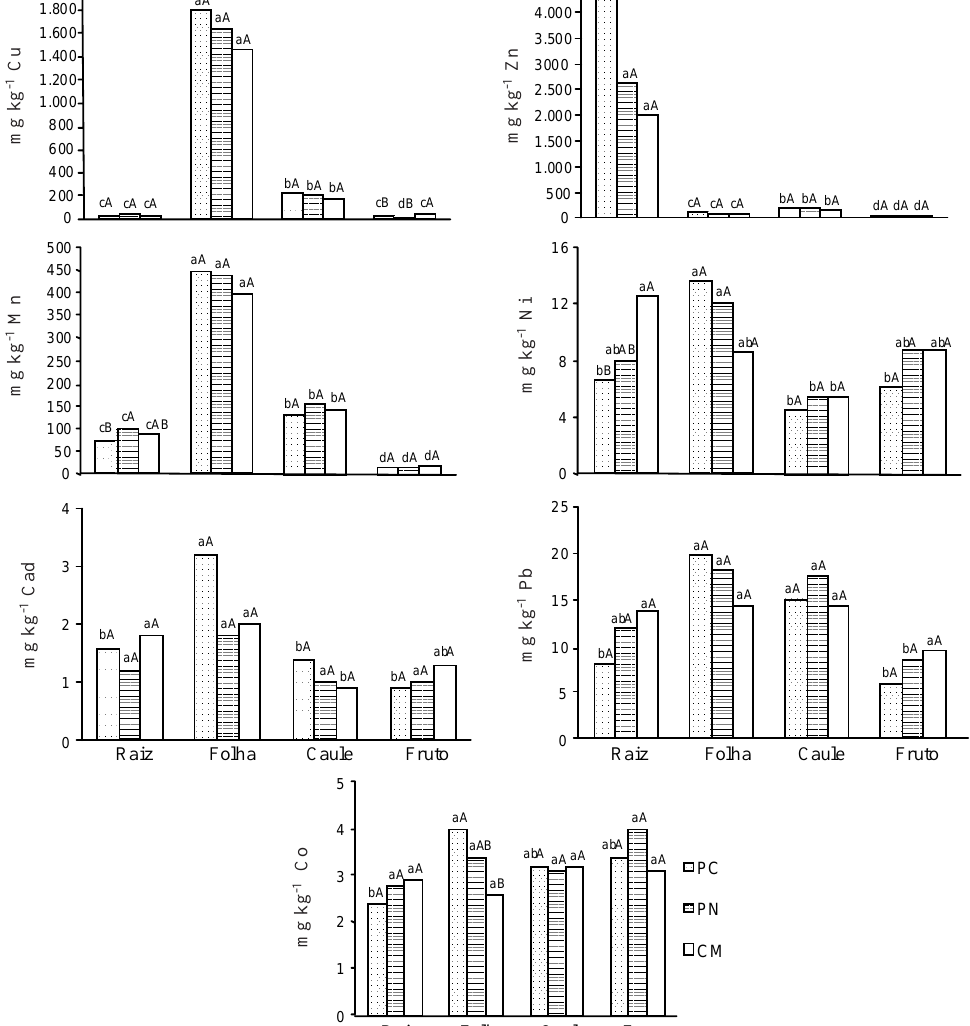
Figura 2. Teores de metais pesados em partes da planta de tomate, nos quatro sistemas de preparo do solo. Médias seguidas das mesma letra minúscula, para órgãos da planta, e maiúscula, para sistema de preparo do solo, não diferem significativamente pelo teste de Tukey a 5 %. PC: Plantio convencional; PN: Preparo em nível; CM: Cultivo